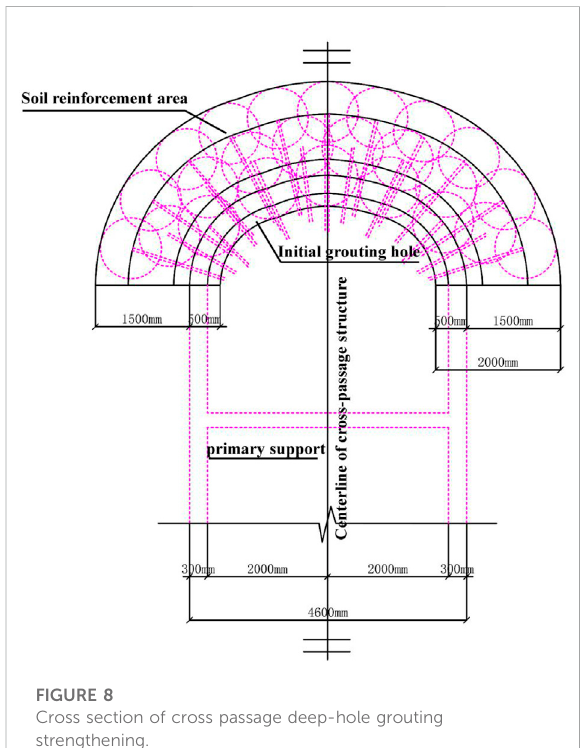
FIGURE 8 Cross section of cross passage deep-hole grouting strengthening.